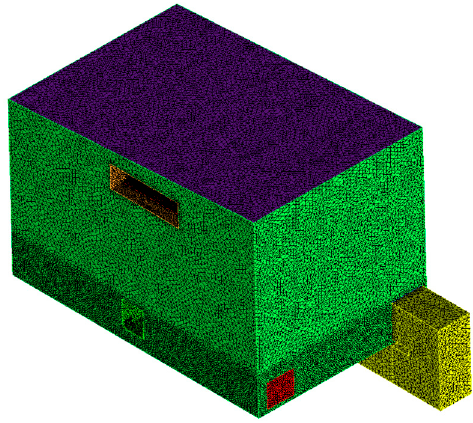
Figure 5. Mesh division of the broiler chamber in ICME CFD (integrated computer engineering and manufacturing code for computational fluid dynamics).